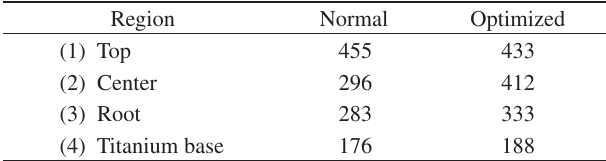
Table 3. Vicker’s microhardness values (HV100 g).